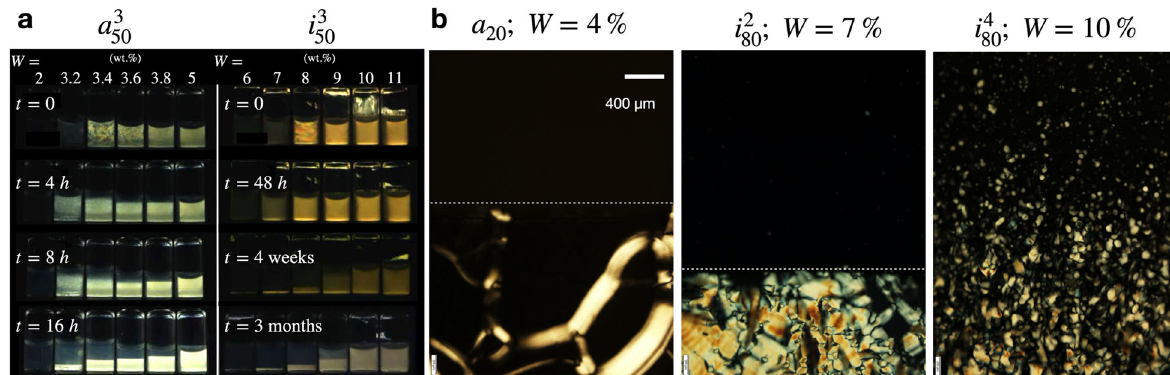
Fig. 3 Phase separation dynamics in suspensions with different CNC lengths. a Macroscopic phase separation (vial diameter: 11 mm) as a function of (long CNCs) and i 3 (short CNCs). While separation is near complete within a day for a 3 time t and global CNC concentration W for a 3 50 50 dispersed in the isotropic phase of i 3 even after several months. Time lapse movies of the processes are shown in Supplementary Movies 1 and 2. b The 50 corresponding experiment on microscopic scale, with vertically stored (2 months) sealed fl at capillaries fi lled with long ( a 20 ), intermediate ( i 2 ( i 4 ) CNC fractions. Further details in Supplementary 80